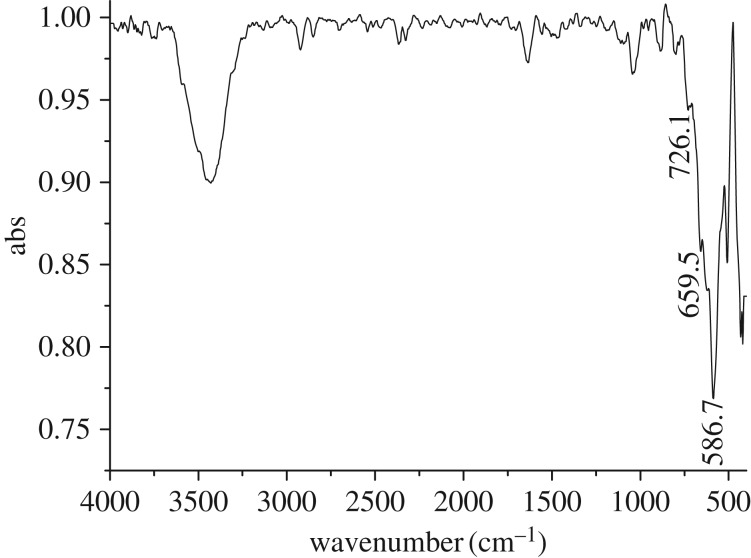
FT-IR spectrum of Fe3O4.